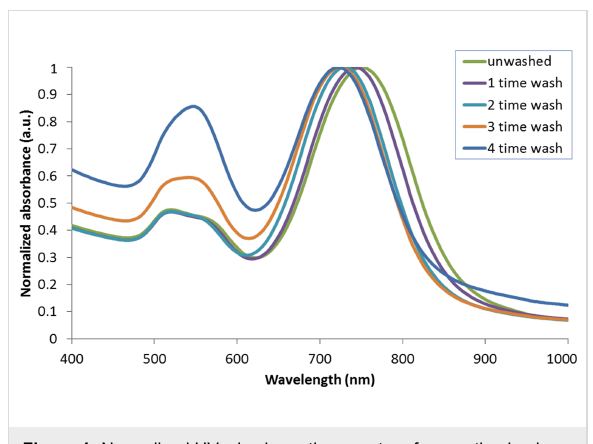
Figure 1: Normalized UV–vis absorption spectra of as-synthesized AuNRs and AuNRs washed one, two , three and four times by centrifu- gation.